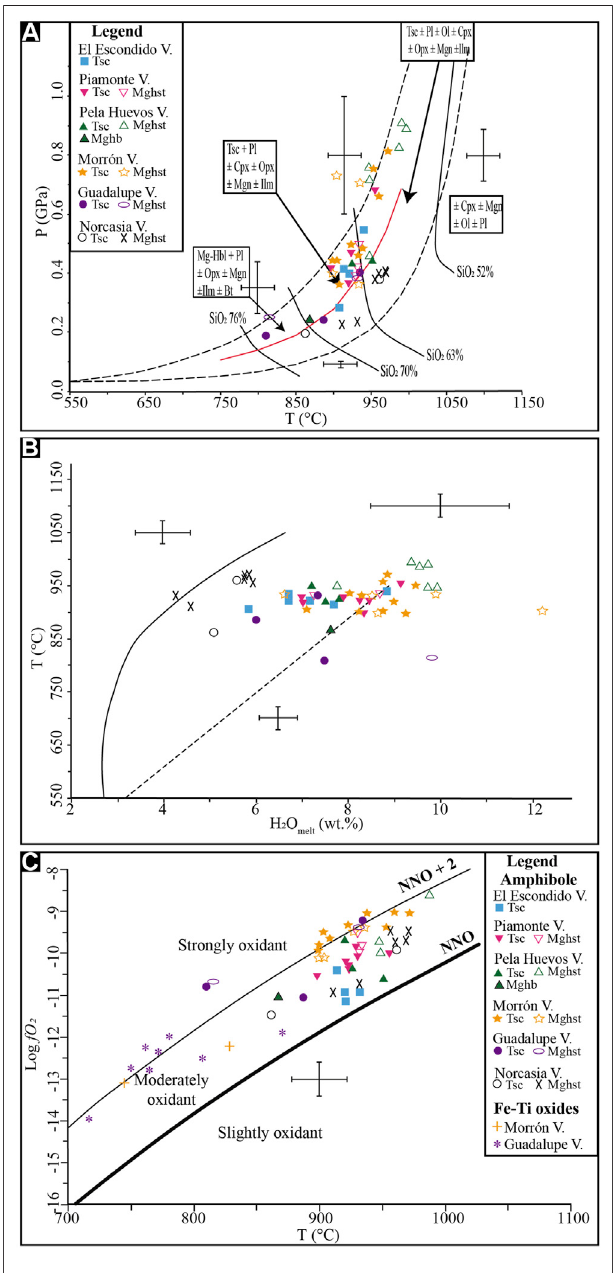
FIGURE 9 | Crystallization conditions based on amphibole geothermobarometryafterRidol fi etal.(2010)andRidol fi &Renzulli(2012). (A) Tvs.Pdiagram,isoplethsshowtheanhydrousSiO 2 (wt.%)contentofthemelt andP – Tstabilitylimitsofphasesintheboxes,andtheblackdashedlines represent the maximum thermal stability, and the red line divides consistent experimental product with different crystallinity (35 – 50 wt.% at lower T and 12 – 35 wt.% at higher T) (Ridol fi et al., 2010). (B) H 2 O vs. T melt diagram; the black line represents the maximum thermal stability and black dash line represents the lower limit of amphiboles (Ridol fi et al., 2010). (C) T vs. log fO 2 diagram, the curves represent the nickel – nickel oxide (NNO) buffer and NNO+2 (Ridol fi et al., 2010); Fe – Ti oxides (Andersen & Lindsley, 1985) are includedin thisdiagram toobservetheir crystallization conditions withrespect to amphibole. Error bars represent the expected uncertainty in T (± 23.5 ° C), P ( Continued )